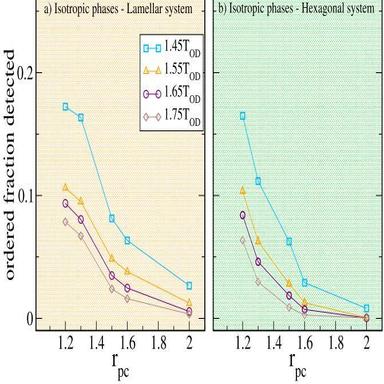
The fraction of particles identified by the neural network as belonging to local environments of ordered phases at different temperatures within the isotropic phase, as a function of the size used to construct the point cloud, pc. Figure (a) corresponds to the lamellar system and Figure (b) to the hexagonal system. Notably, at shorter pc values, the network detects a significant proportion of particles exhibiting mesophase-like order within the isotropic phase, with this behavior becoming more evident at te